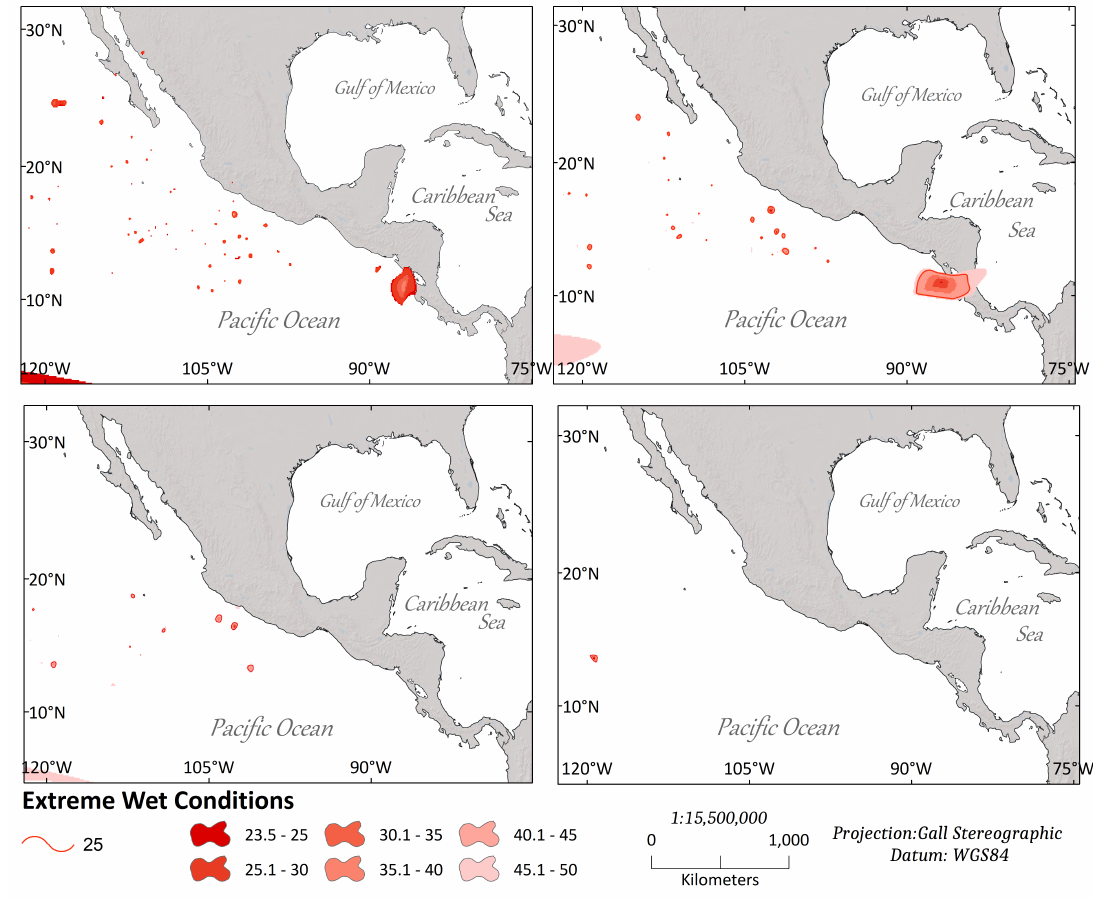
Figure 7. Same as Figure 4, but for Eastern Tropical Pacific ocean cyclones.( upper left ) All cyclones, ( upper right ) named cyclones, ( lower left ) all hurricanes, ( lower right ) intense